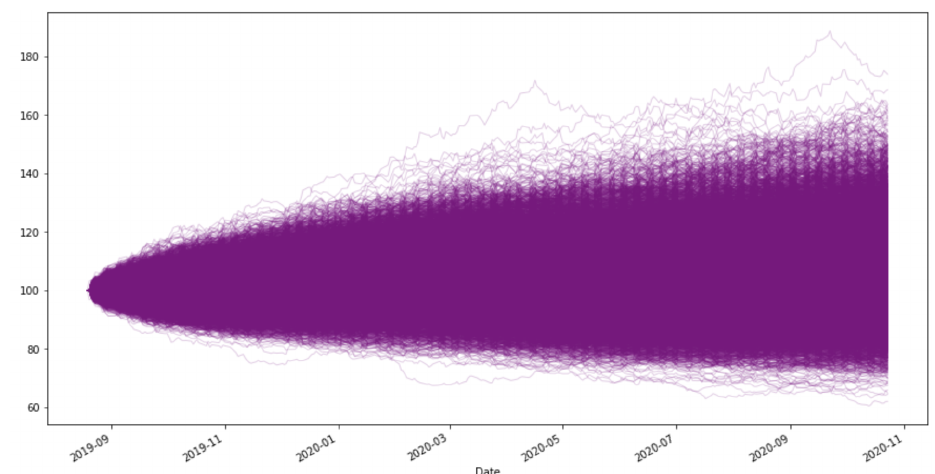
Figure 8. Monte Carlo simulations for the VolTarget portfolio with historical volatility with VT set to 13% (source: authors’ calculations).